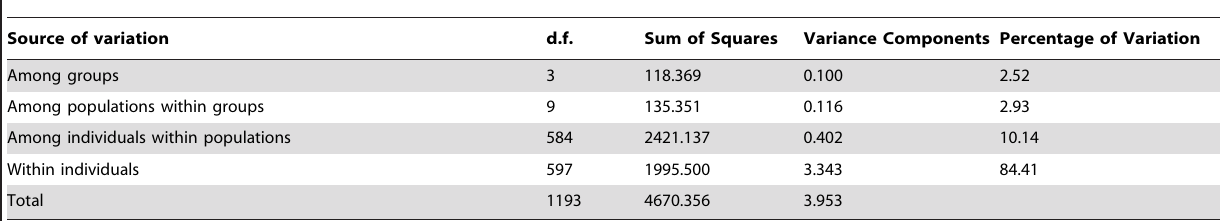
Table 3. Analysis of Molecular Variance (AMOVA) results when populations are grouped by river basin.